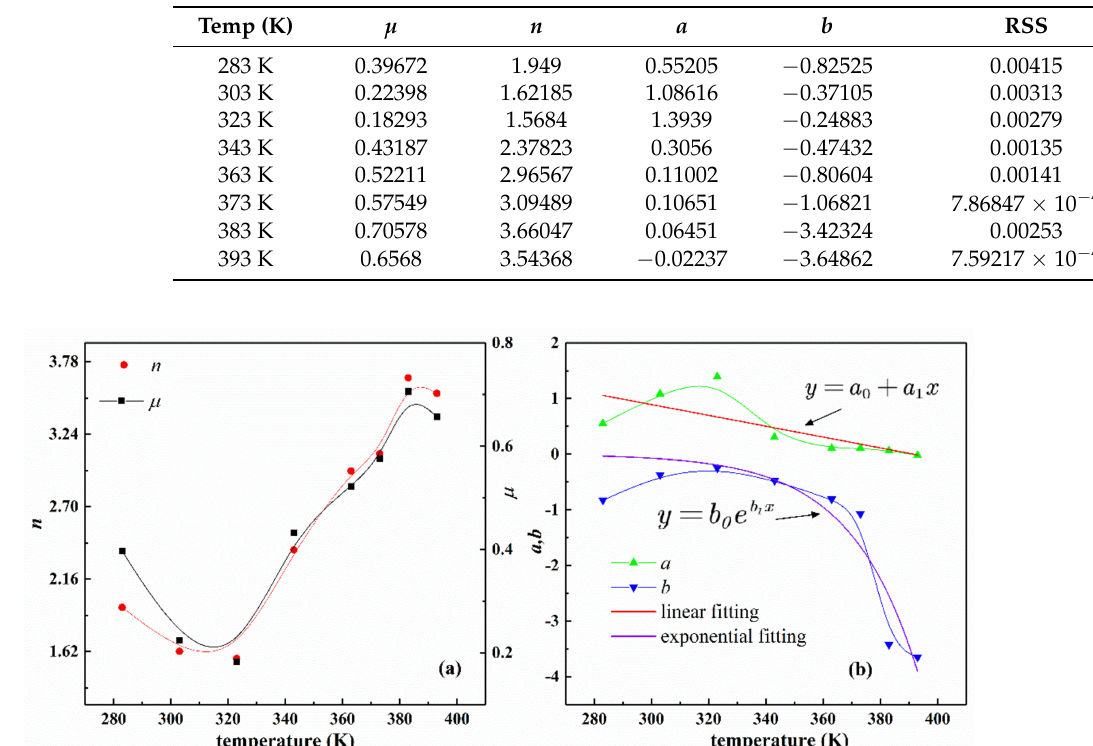
Figure 13. Temperature-dependent curves of fitting parameters of NR-1 under uniaxial tension at different temperatures by improved eight-chain model. ( a ) Curves of parameters n , µ with temperature; ( b ) Curves of parameters a , b with temperature and the corresponding fitting